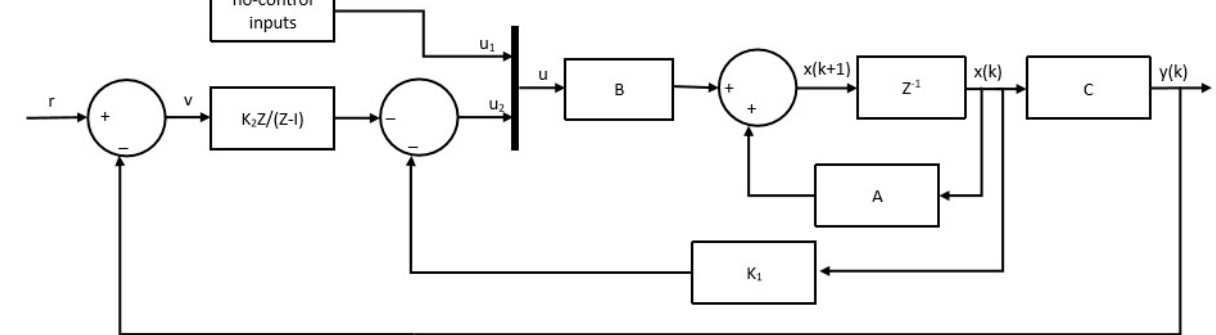
Figure 9. Closed loop of the system for tracking the indoor temperature by introducing an integrator and splitting the feedback gain.